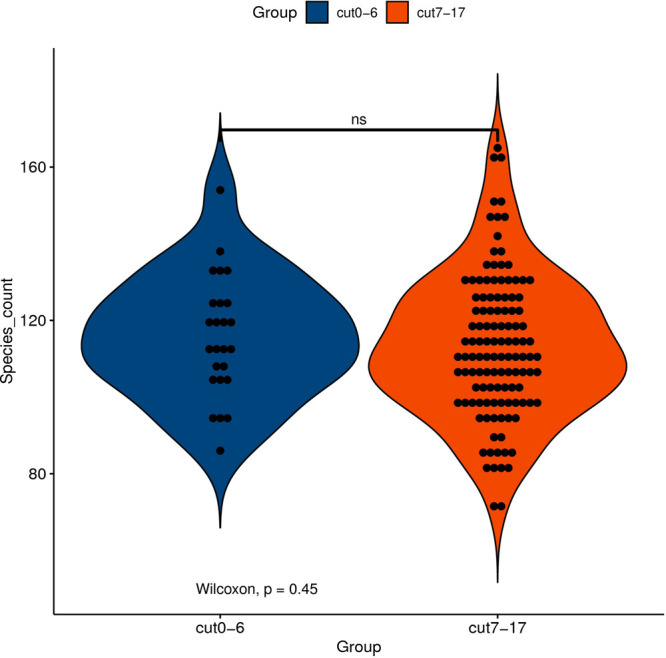
The abscissa represents the grouping of samples, and the ordinate represents the number index of species under different grouping. The external shape is the density distribution, and the internal black spot represents the position of the sample. Asterisk (*) indicates significant difference (0.01 < P < 0.05); double asterisk (**) indicates extremely significant difference (P < 0.01); NS indicates no significant difference.